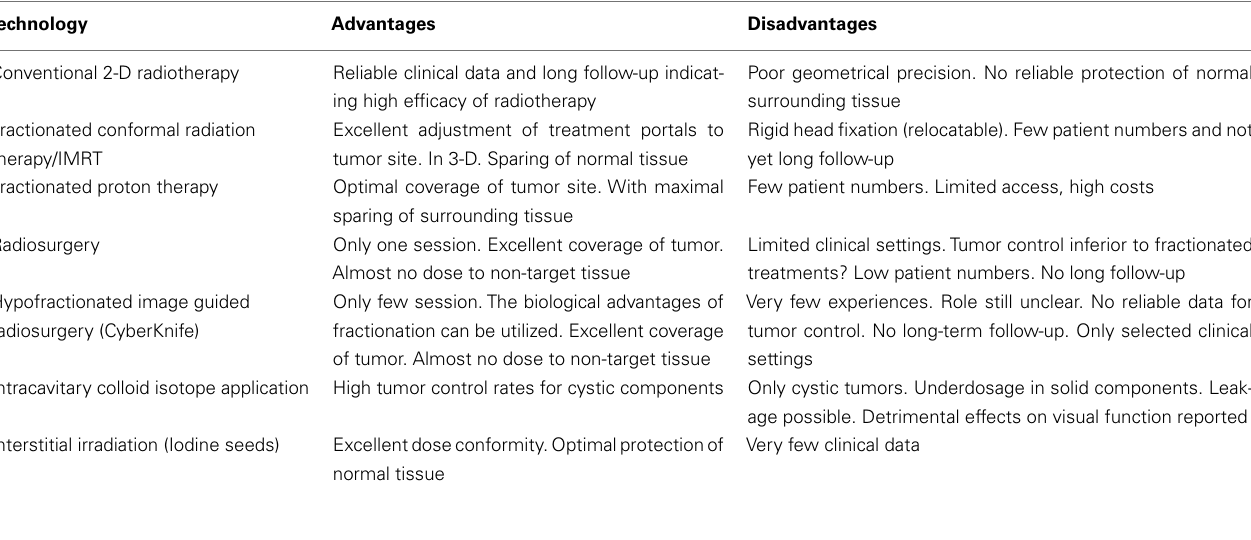
Table 6 |Advantages and disadvantages of modern treatment technologies in radiotherapy of